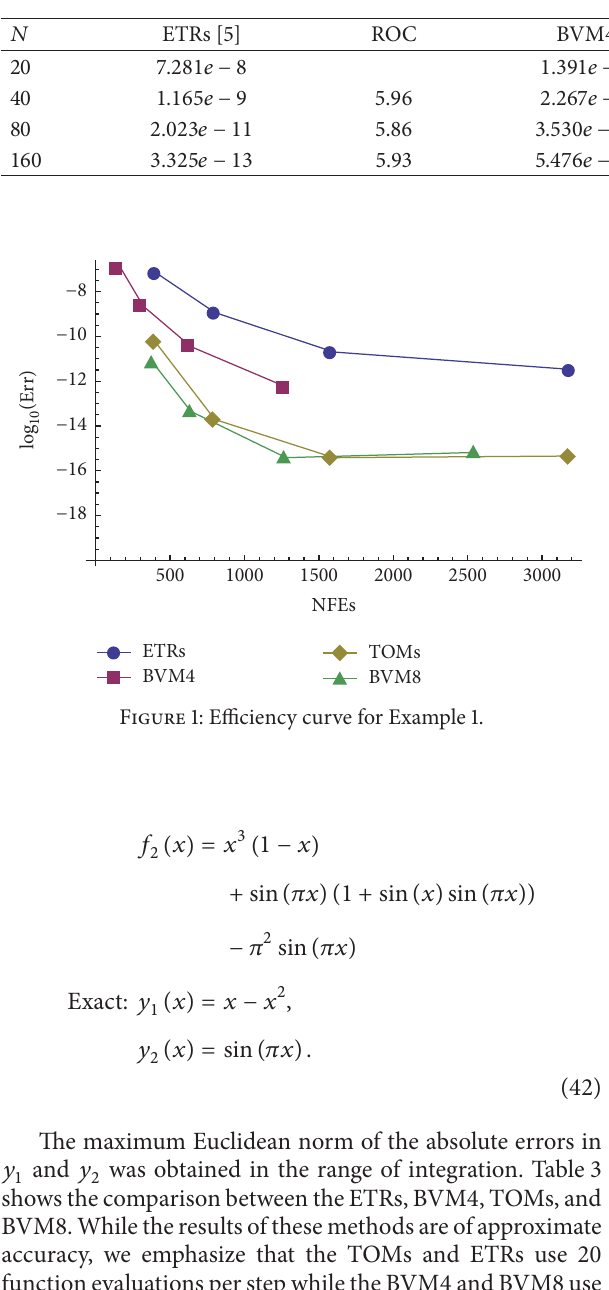
Table 2: Maximum Errors for different stepsizes for Example 1.